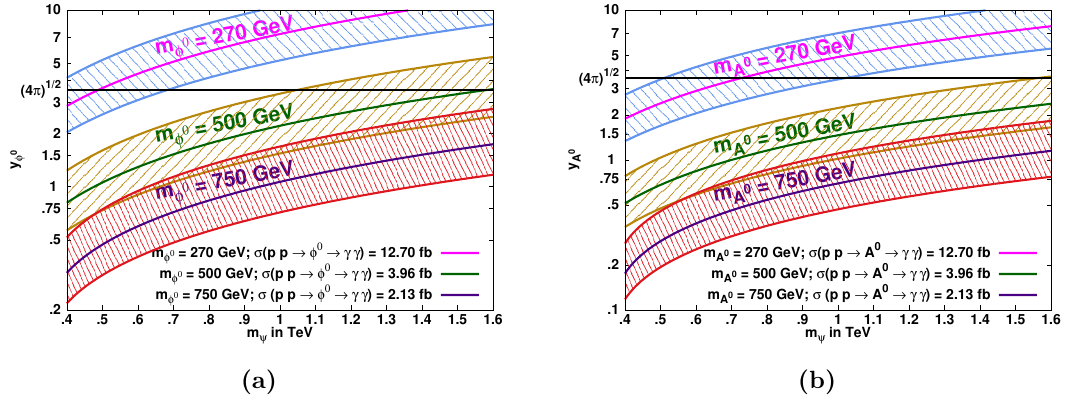
(cid:30) 0 =A 0 p s = 13 TeV